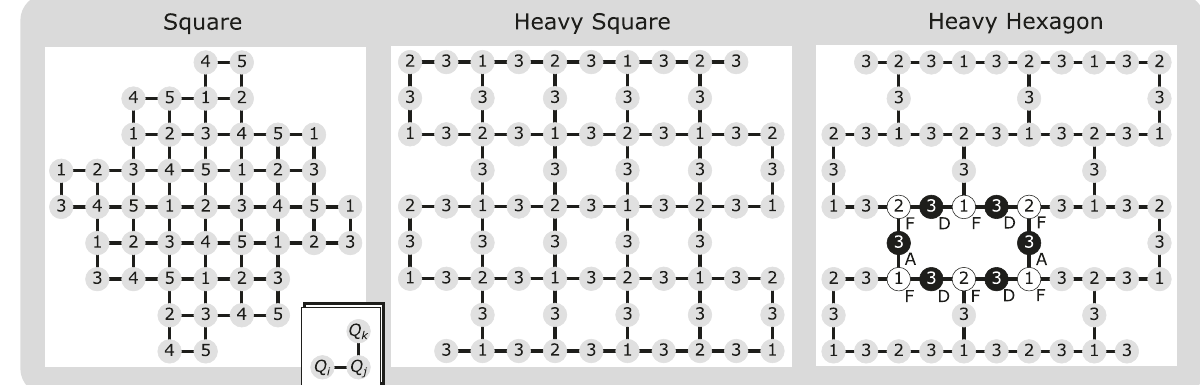
Fig. 3 Lattice and frequency pattern examples. Lattices are capable of d = 5 codes. Patterns of qubit frequencies avoid all conditions in Table 1. Statistical model is applied to these examples and to equivalent lattices at d = 3 and d = 7 (see Supplementary Figs. 1 – 9). Square lattice includes 49 qubits in a 5-frequency pattern. Heavy-square lattice includes 73 qubits in 3-frequency pattern. Heavy-hexagon lattice includes 65 qubits in 3-frequency pattern. In a portion of the heavy-hexagon lattice, we indicate qubits ’ intended gate roles: control (black circles) or target (white circles), as well as code roles: data (D), ancilla (A), or fl ag (F) 37 . Inset shows relative positions of qubits for collision de fi nitions of Table 1. Q j is coupled to nearest-neighbors Q i and Q k . Qubits Q i and Q k are next nearest neighbors.